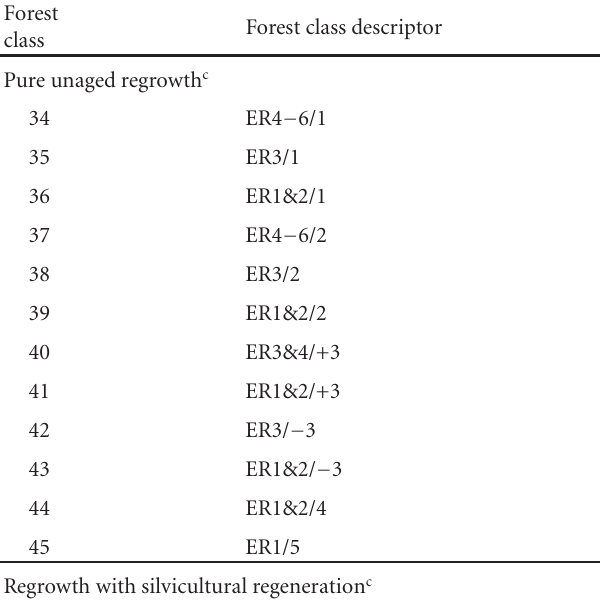
Table 1: Forest classes of Tasmanian state forest and their